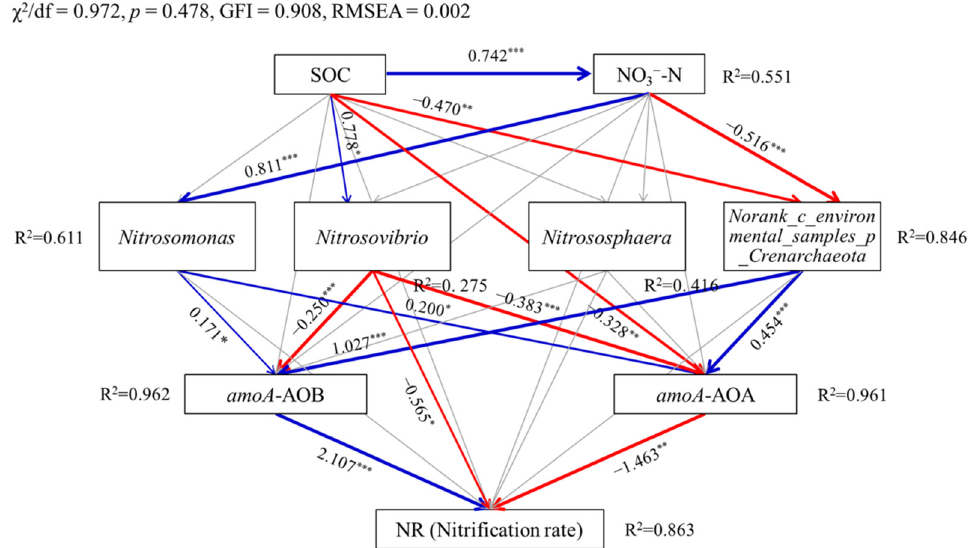
Figure 5. Structural equation models showing the effects of soil properties (SOC and NO 3 − -N) induced by biochar addition, dominant taxa of ammonia-oxidizing microorganisms, and amoA gene abundance on the soil nitrification rate (NR) at the genus level. Blue and red arrow lines indicate significant positive and negative relationships, respectively. Gray arrow lines indicate nonsignificant relationships. Numbers above arrow lines are standardized path coefficients. R 2 indicates the proportion of variance explained by the model. *** p < 0.001; ** p < 0.01; * p < 0.05.